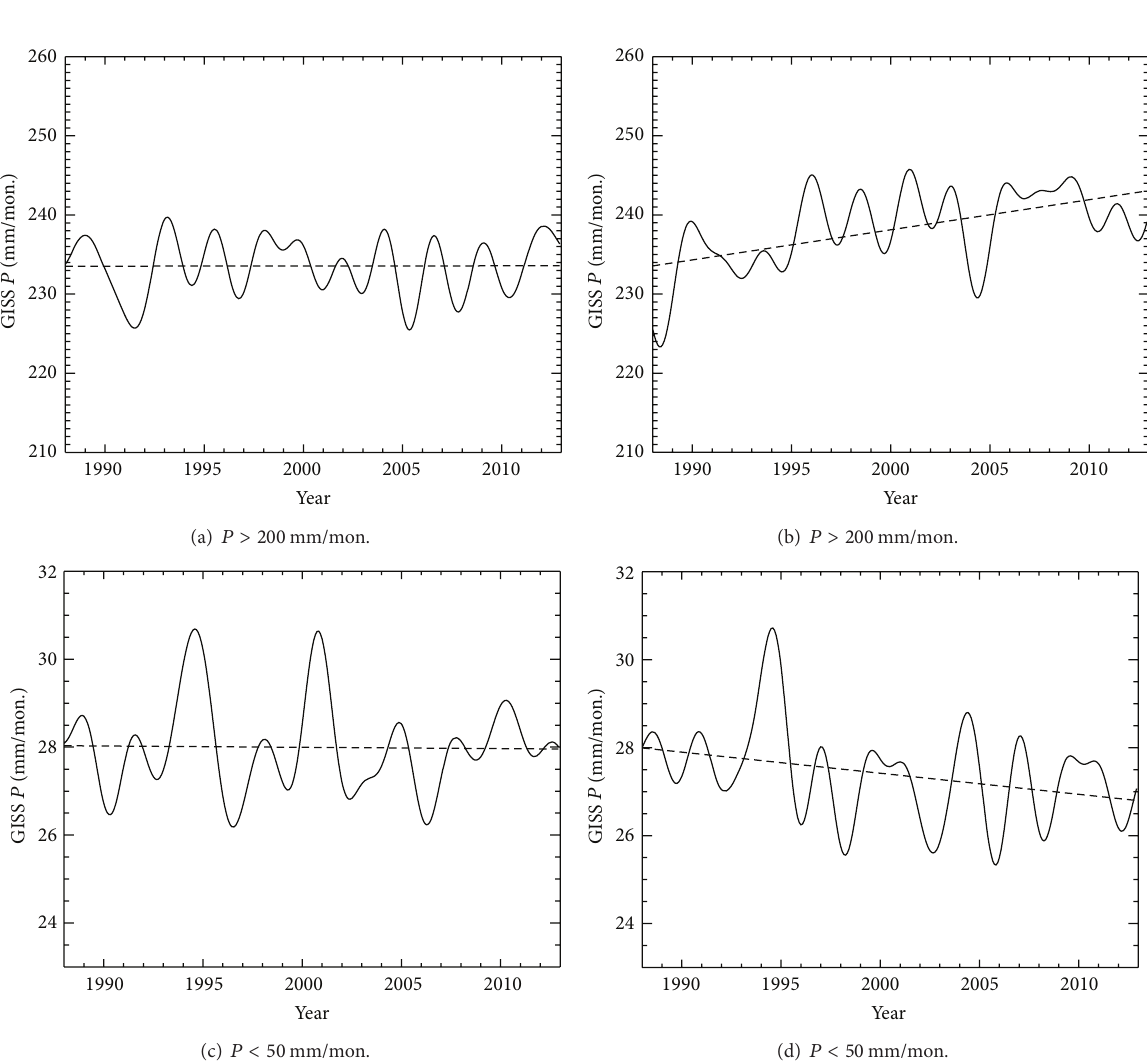
Figure 2: Low-pass filtered time series for precipitation ( 𝑃 ) from GISS/HYCOM. (a) 𝑃 over high-precipitation area ( 𝑃 > 200 mm/mon.) from the control simulation (solid line) and trend (dashed line). (b) 𝑃 over high-precipitation area from the historic simulation (solid line) and trend (dashed line). (c) Same as (a) except for areas with precipitation < 50 mm/mon. (d) Same as (b) except for areas with precipitation < 50